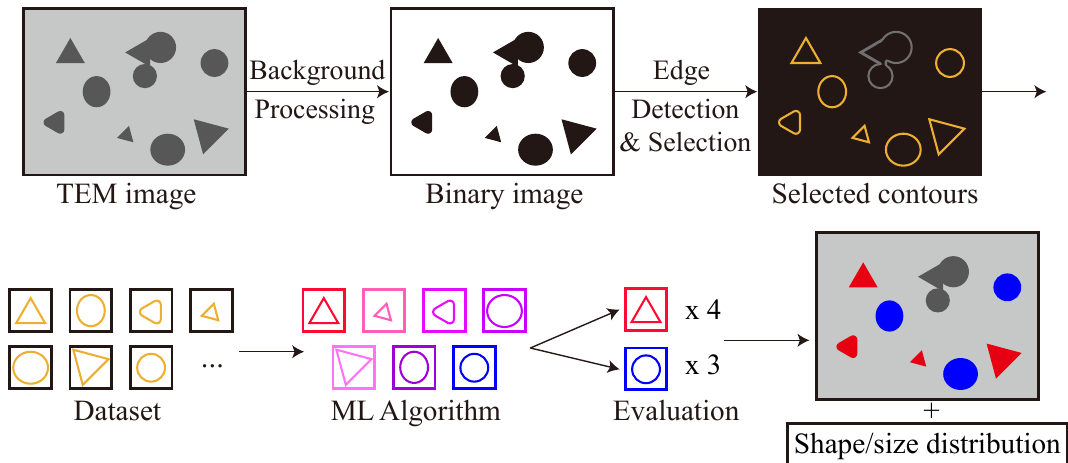
Figure 1. Schematic workflow of the methodology. The upper panel shows the imaging pre-processing steps and the lower panel illustrates the particle shape classification and evaluation via the ML